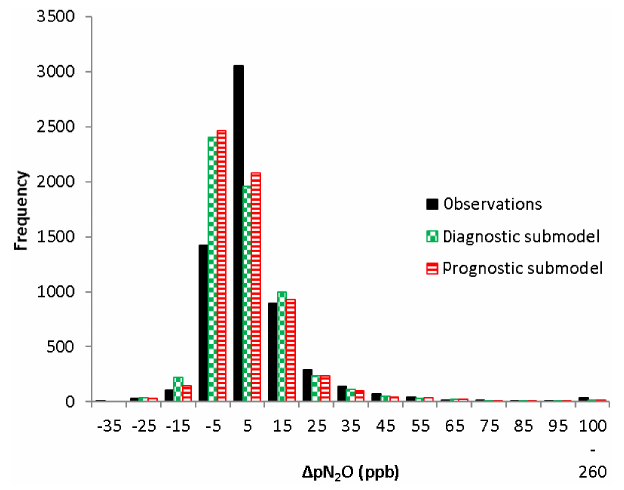
Figure 12. Frequency distribution of (cid:49)p N 2 O in the observations (solid black), and the optimised simulations of the diagnostic sub- model (green squares) and the prognostic submodel (red